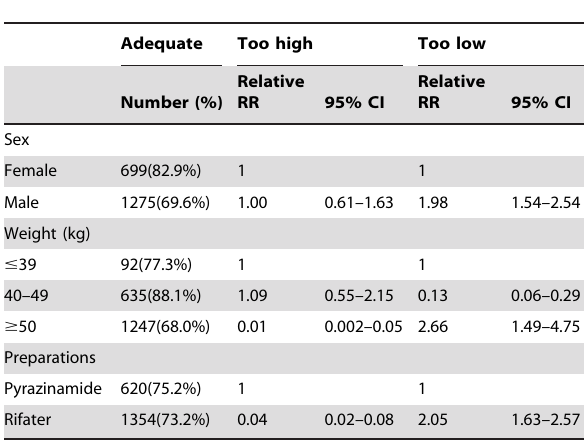
Figure 8. Consistency with Taiwan Guidelines in prescribing